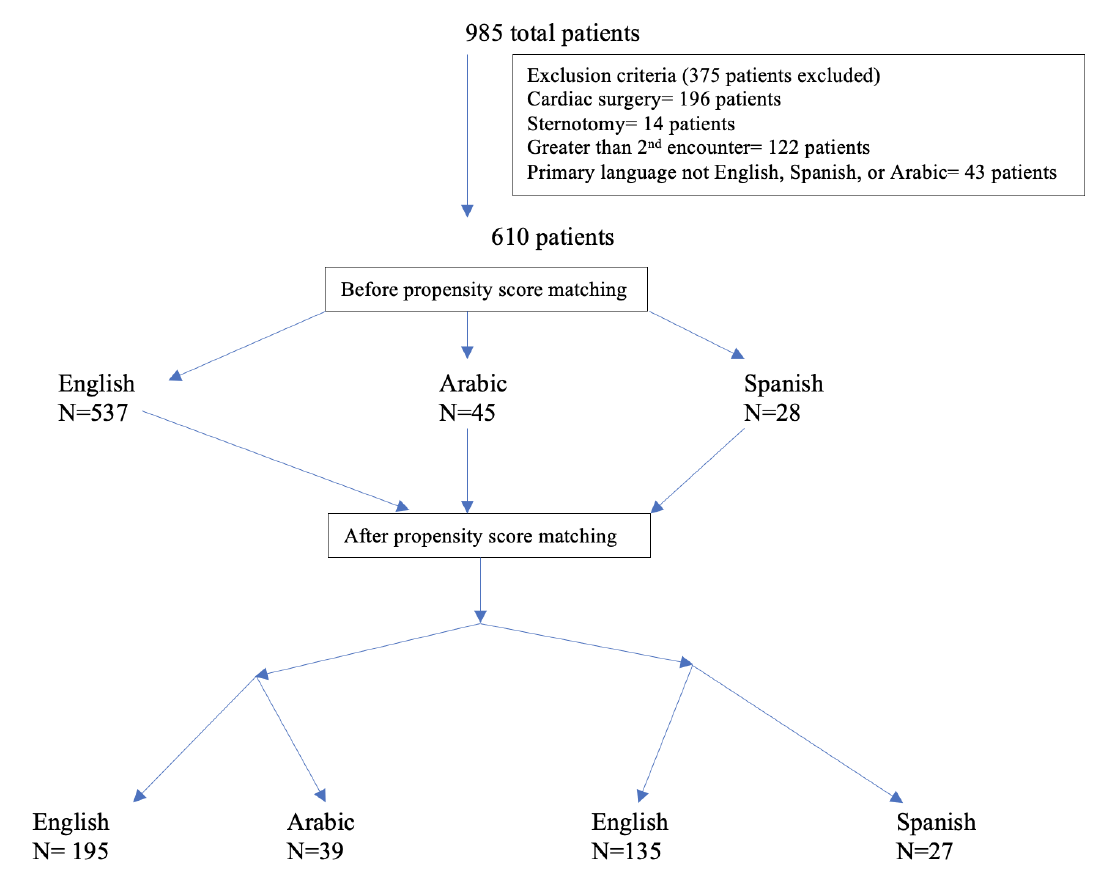
Figure 1. Number of patients with exclusion criteria and propensity matching applied. Table 1. Opioid Equivalents and Pain Scores by Language Prior to Propensity Score Matching. Median OEs per kilogram of body weight and median pain scores for each language group are reported in Table 1. Of note, out of the total reported 13,574 pain scores, 11,899 (87.6%) were FLACC scores. Other scores utilized were NRS (982 pain scores, 7% of total scores) and Wong – Baker Generalized pain scores (534 pain scores, 4% of total score). Opi- oid equivalents were both presented as continuous opioid infusions (morphine, fentanyl or hydromorphone) and as needed bolus opioids. A total of 105 of 961 had only continu- ous opioid infusions, 255 encounters had only bolus opioids, and 554 encounters had both bolus and continuous opioids. There was minimal difference in opioid consumption and lower pain scores in the AS patients compared to ES patients. There was a higher opioid consumption by SS patients compared to ES patients at all measured time periods in the first 48 h postoperatively, but no significant difference in pain scores between SS and ES patients.